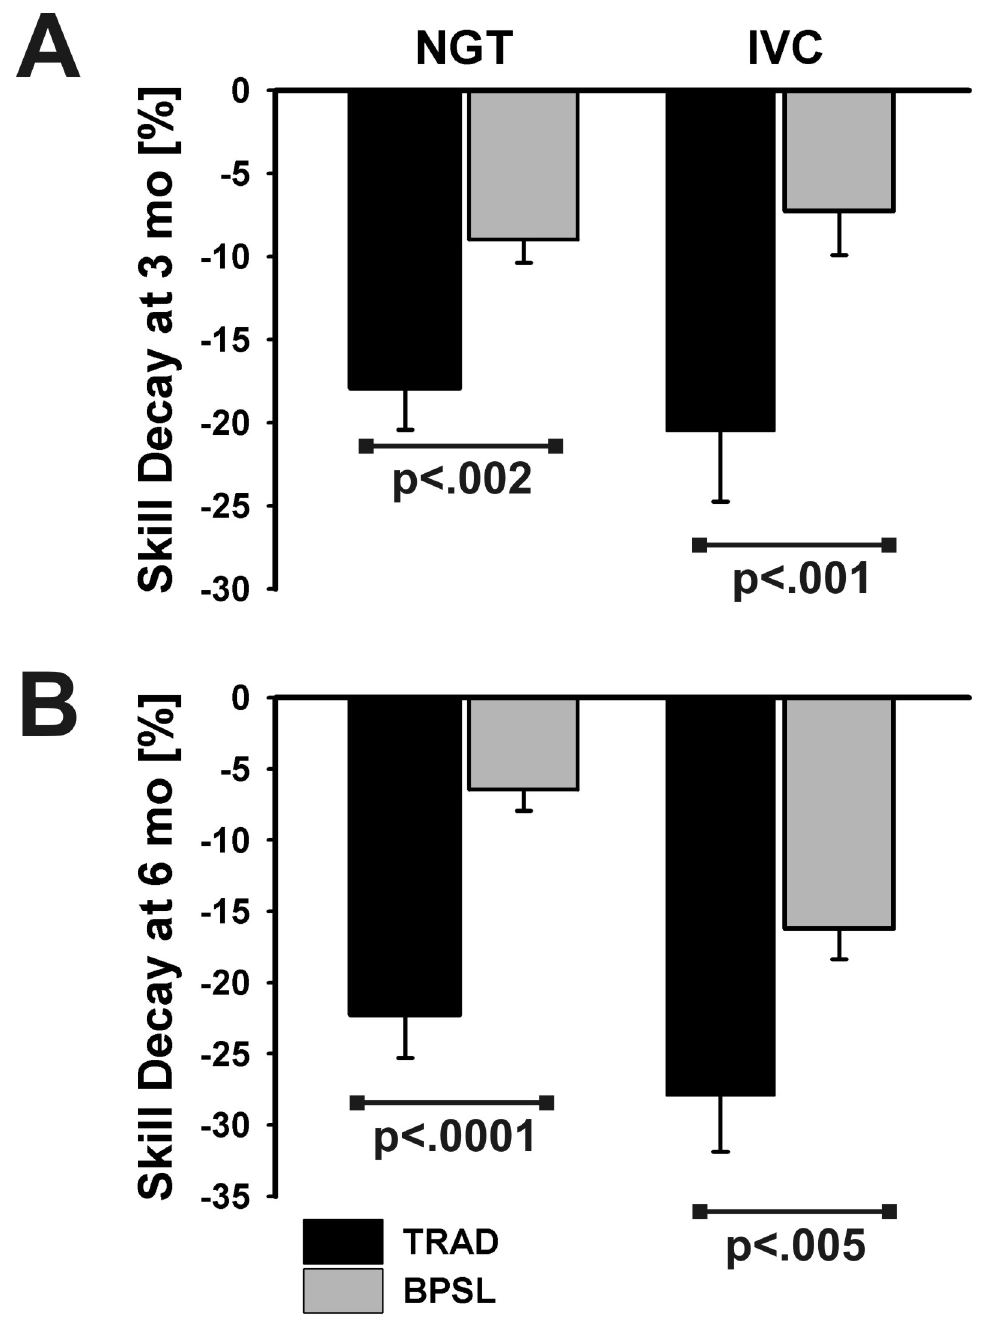
Figure 2. Loss of skills level expressed as percentage of points on the corresponding binary checklist (NGT or IVC) at 3 (Figure 2A) and 6 months (Figure 2B) after initial training, respectively (error bars refer to SEM). NGT = nasogastral tube insertion, IVC = intravenous cannulation, BSPL = Best Practice Skills Lab Training, TRAD = Traditional “see one, do one” teaching.